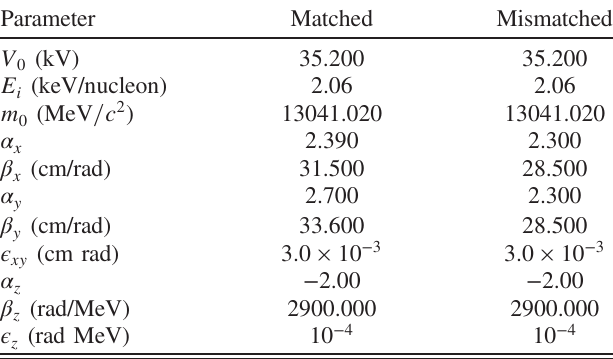
TABLE II. TRANSOPTR RFQ simulation parameters as used in Fig. 3, for the matched and unmatched cases, both with 14 N. The transverse emittance ϵ is used as an input emittance for xy both x and y dimensions. Twiss parameters for the longitudinal dimension have a subscript z . Starting coordinate s ¼ 0 corre- sponds to the inner surface of the RFQ vacuum tank, 8.8 cm before the